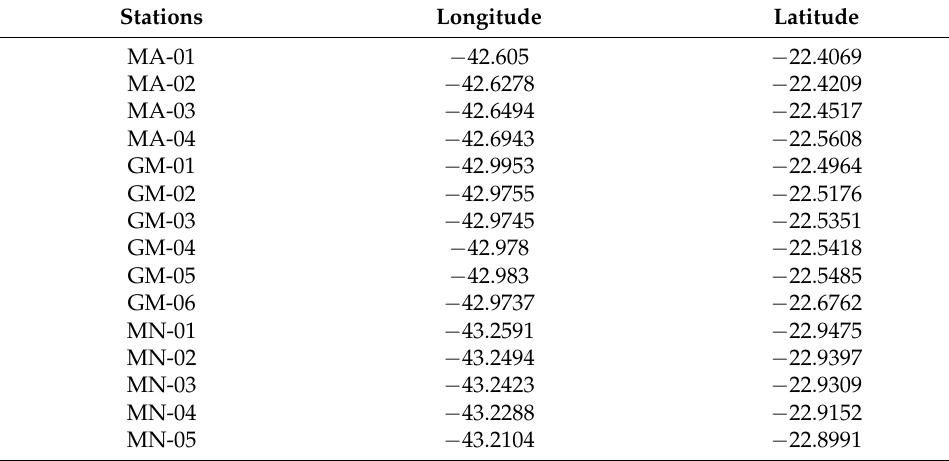
Table 1. Coordinates of the